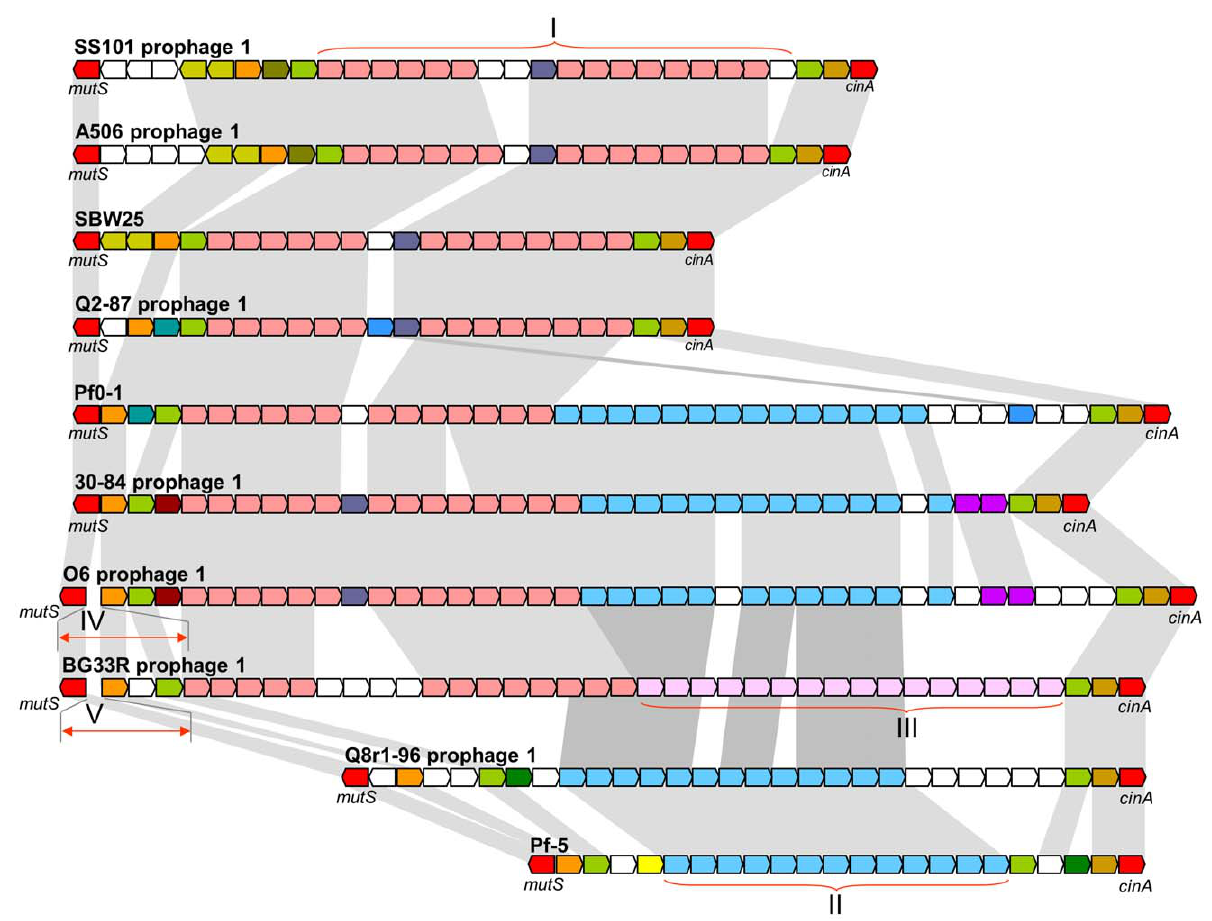
Figure 5. Comparative organization of prophages in the mutS-cinA region of ten genomes of the P.fluorescens group. Predicted genes and their orientation are shown by arrows. The conserved housekeeping genes mutS and cinA are colored red, whereas strain-specific genes are colored white. Homologous prophage genes are indicated by other colors and connected with grey shading. Roman numerals correspond to conserved blocks of bacteriophage genes shared among strains. The size of genes and intergenic regions are not to